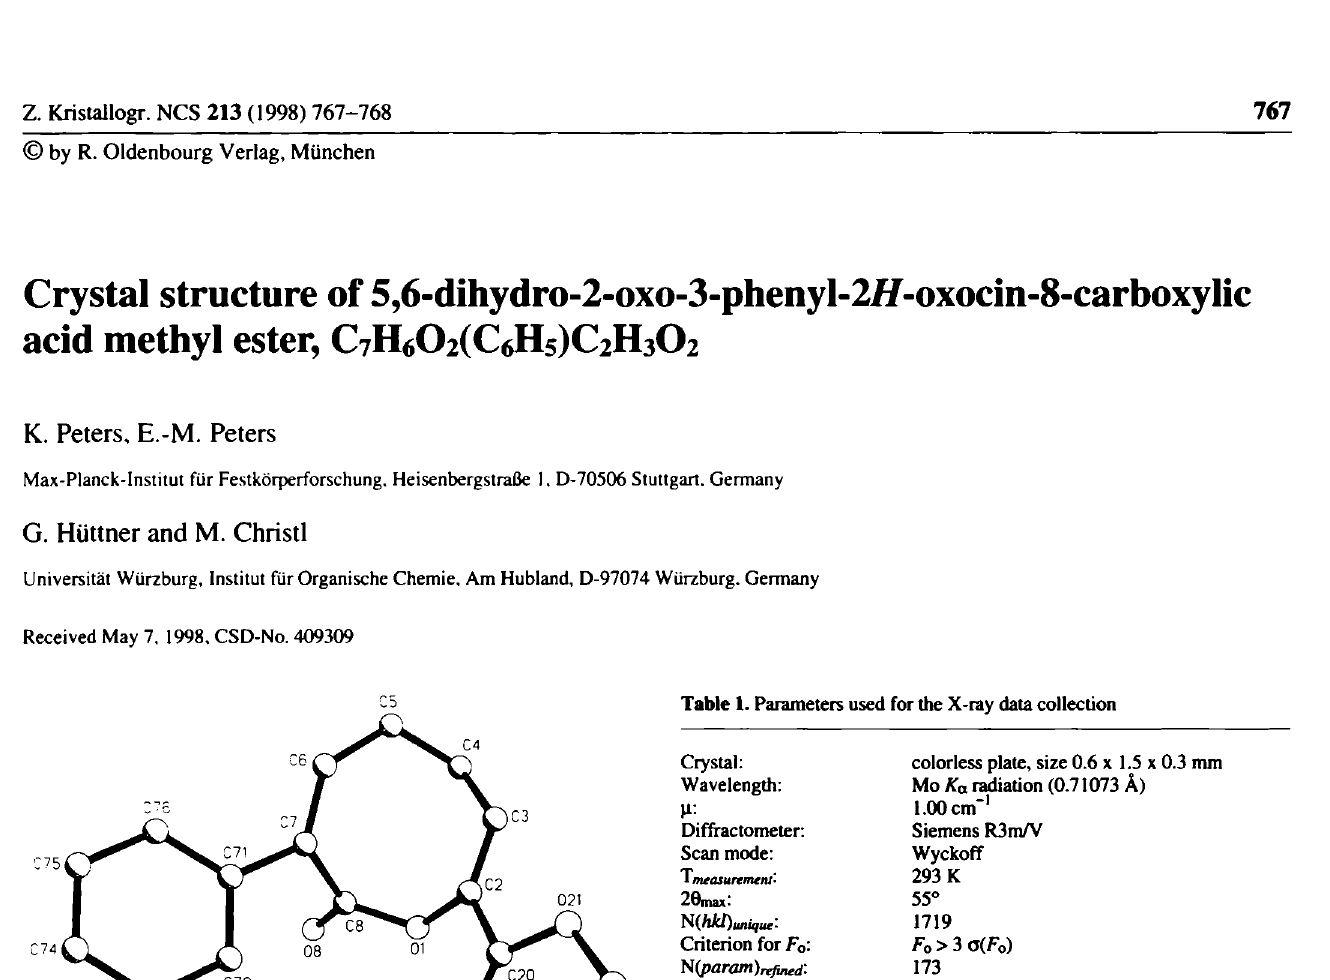
Table 2. Final atomic coordinates and displacement parameters (in Â^)